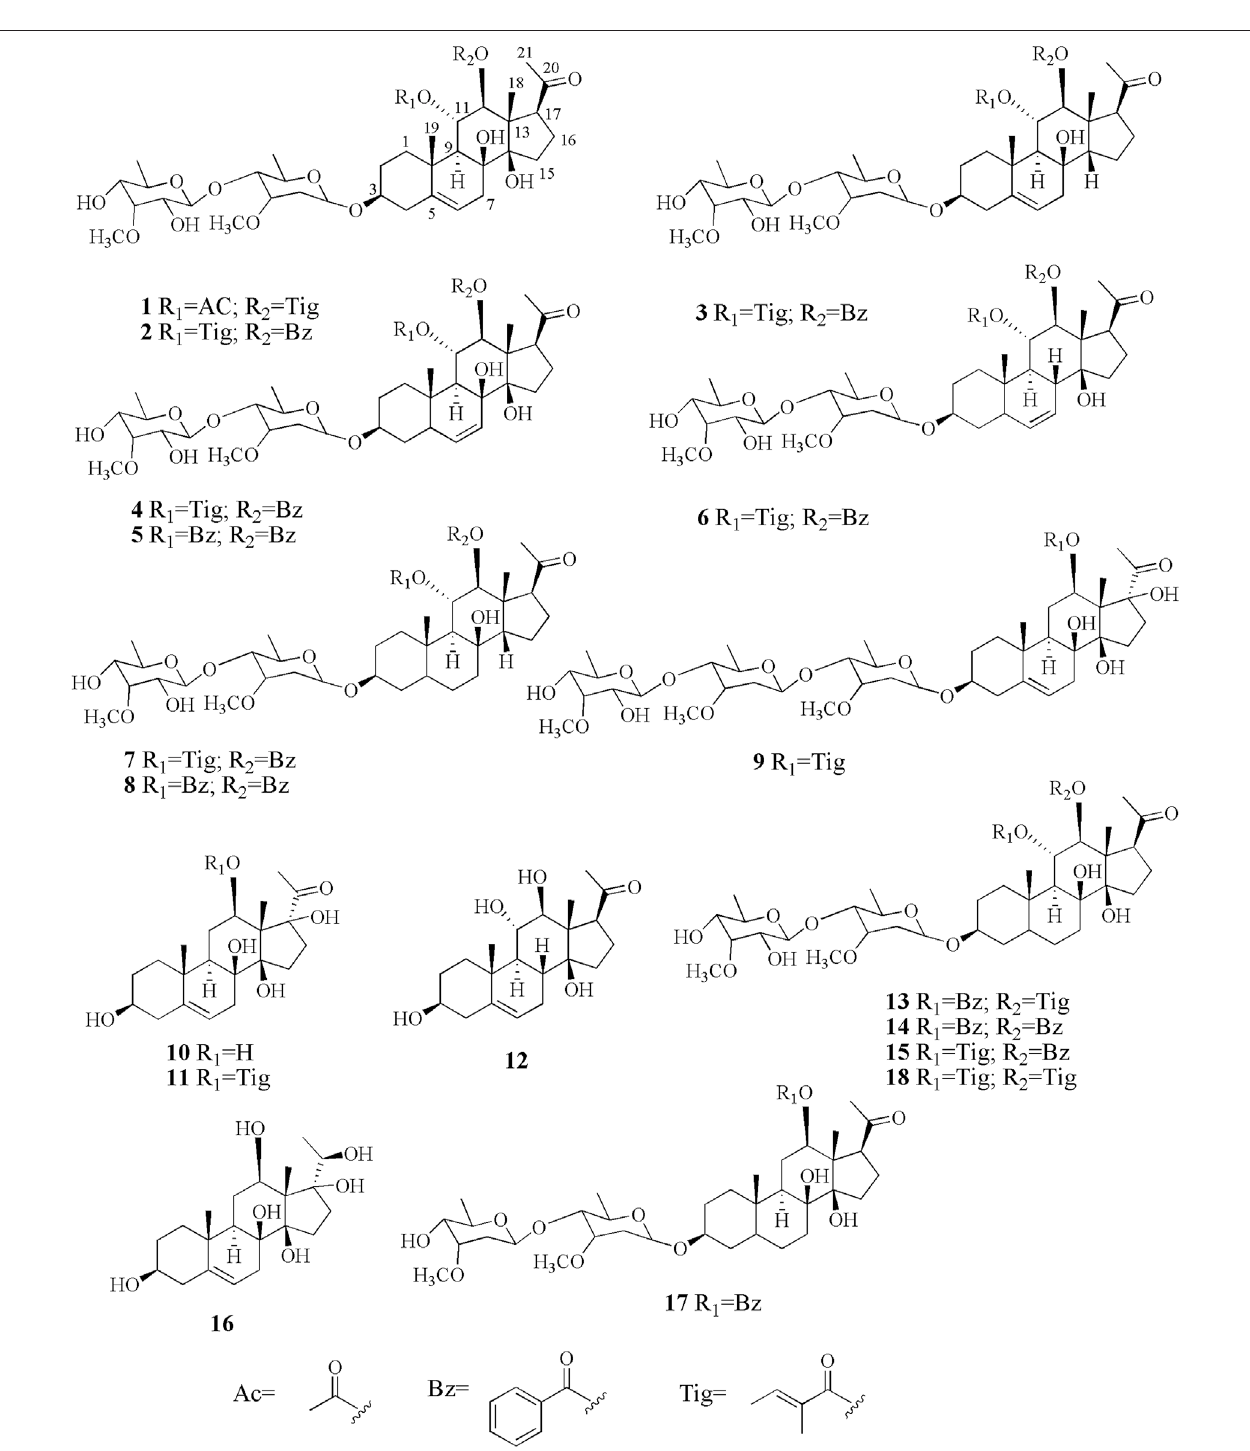
FIGURE 1 | Chemical structures of compounds 1 –